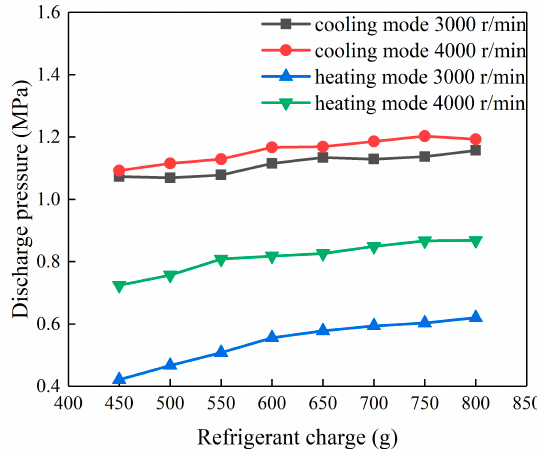
Figure 5. Discharge pressure variations with refrigerant charge.